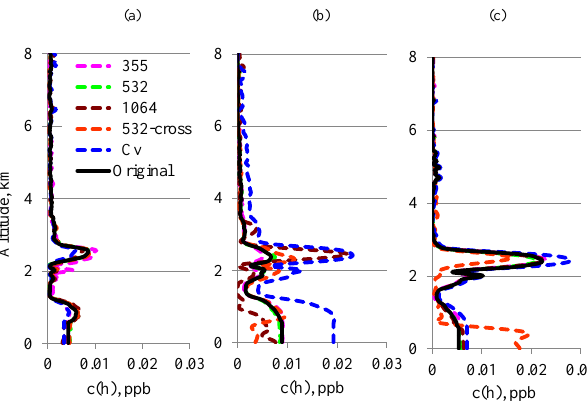
Figure 12. Comparison of PVC profiles, c k (h) , for the two- and three-mode aerosol models (a) , and variations of concentration pro- files, c k (h) , for fine (b) and coarse (c) aerosol modes of the two- mode aerosol model in response to elimination of different parts of input information. In Fig. 12a tags “fine(2)” and “coarse(2)” denote fine and coarse modes of two-mode aerosol model. Tags “fine(2)”, “coarse/sph”, “coarse/nsph” and “coarse(3)” denote fine, coarse spherical, course non-spherical and total course mode of three-mode aerosol model, correspondingly. In Fig. 12b and c tag “Original” means complete set of input data; tag “355” (or 532, 1064) denotes that the lidar signal at 355nm (or 532, 1064) wave- length is excluded; tag “ C V “ denotes that columnar volume concen- trations of aerosol modes are excluded. Lille, 08:00UTC, 19 May